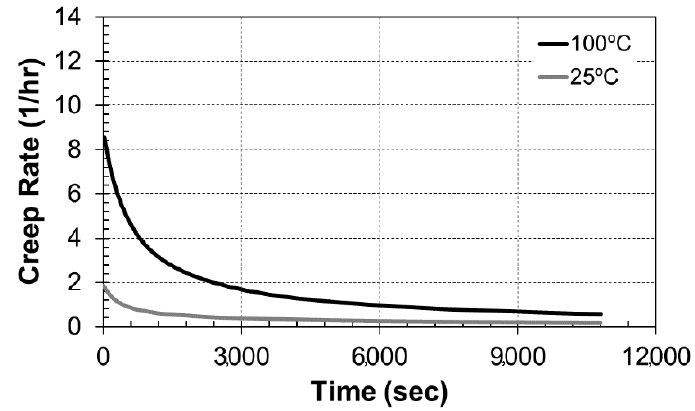
Figure 16. Creep strain as a function of time for a nanocomposite made of 15 v% cellulose and 20 wt. % STO nanoparticles.